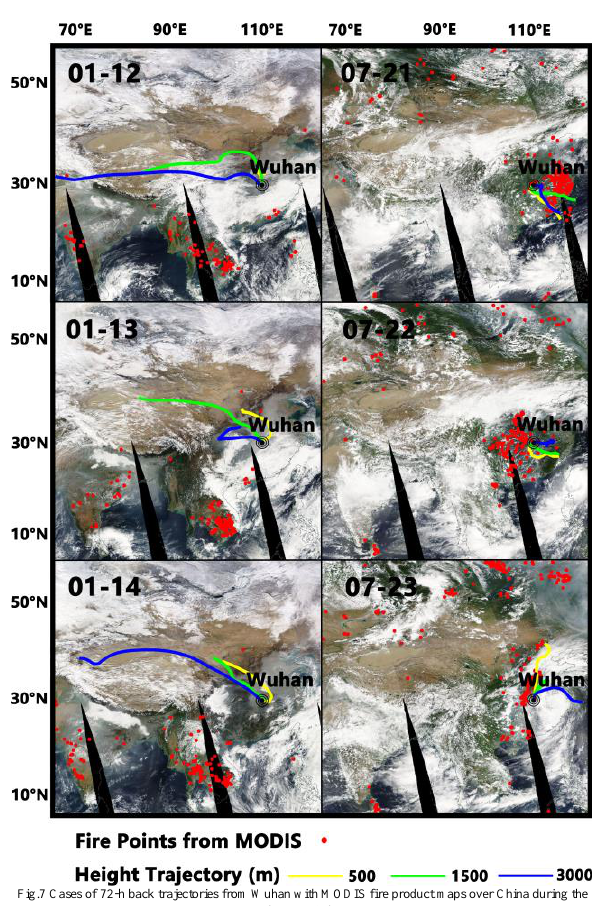
Fig.7 Cases of 72-h back trajectories from Wuhan with MODIS fire product maps over China during the haze periods Cases of 72-h back trajectories at 500 m, 1500 m, and 3000